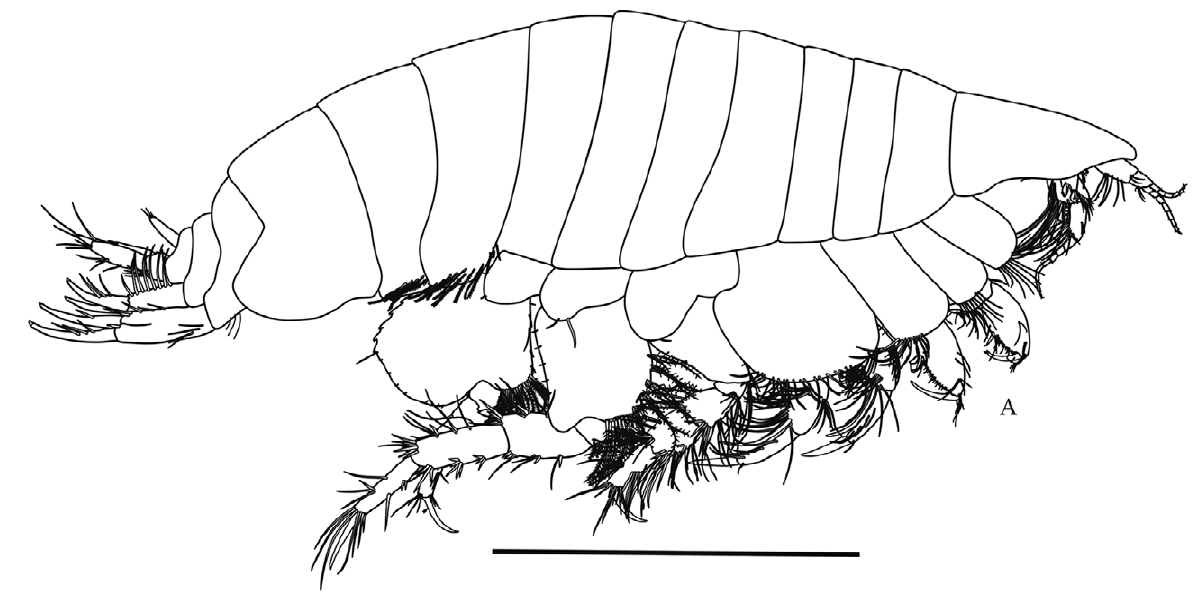
Fig. 1. – Atlantiphoxus wajapi n. sp. paratype female (UERJ 402). Habitus. Scale bar: 1.0